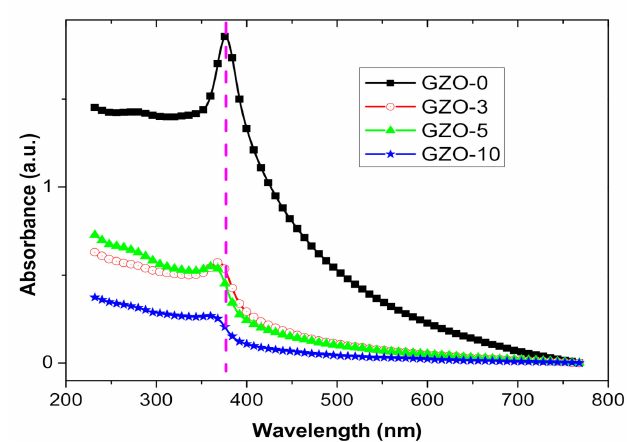
Figure 5. UV-Vis spectra of as-synthesized Ga doped ZnO (GZO-0, GZO-3, GZO-5, and GZO-10) samples with di ff erent gallium nitrate